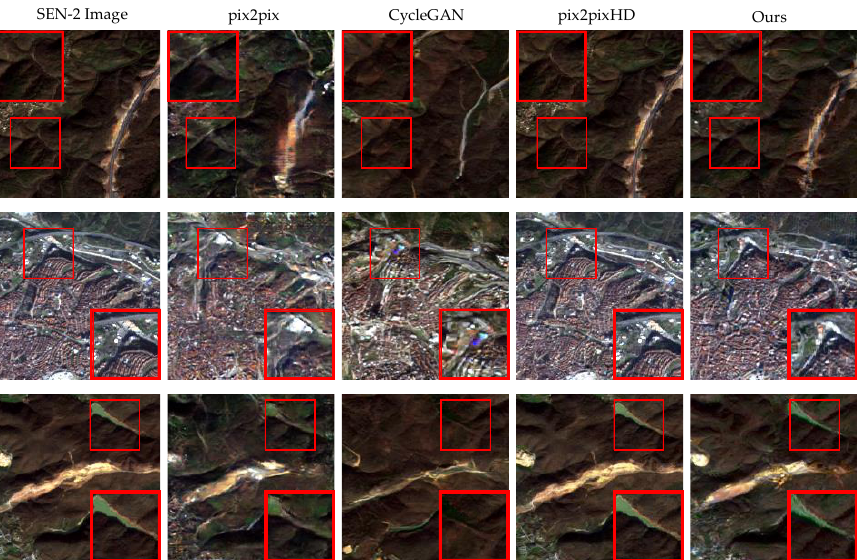
Figure 11. Detailed comparison of Experiment 2. We selected the generated results of different models in three scenarios to compare the details with the SEN-2 reference images. Compared with other image translation models, the proposed model has obvious advantages in improving the generation performance. From left to right: SEN-2 images, images generated by pix2pix, images generated by CycleGAN, images generated by pix2pixHD, and the images generated by our model.